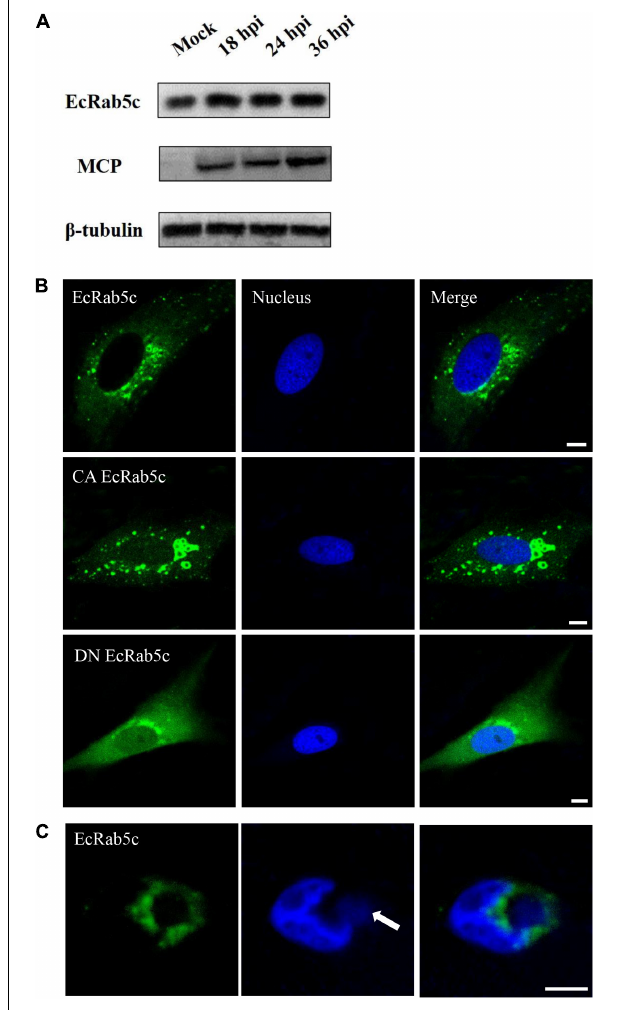
FIGURE 1 | Expression patterns and subcellular distribution of EcRab5c. (A) EcRab5c and viral protein level were detected at different times post SGIV infection. GS cells were collected at 18, 24, and 36 hpi for Western blotting, and β -tubulin was used as the internal control. (B) Distribution pattern of EcRab5c, CA EcRab5c, and DN EcRab5c. GS cells were transfected with pEGFP-EcRab5c, pEGFP-CA EcRab5c, and pEGFP-DN EcRab5c, respectively. Scale bars are 5 µ m. (C) EcRab5c located near the virus factory. GS cells transfected with pEGFP-EcRab5c were infected with SGIV and fixed at 24 h. The nucleus and virus factory were stained by Hoechst 33342. The white arrow shows the virus factory. Scale bars represent 10 µ